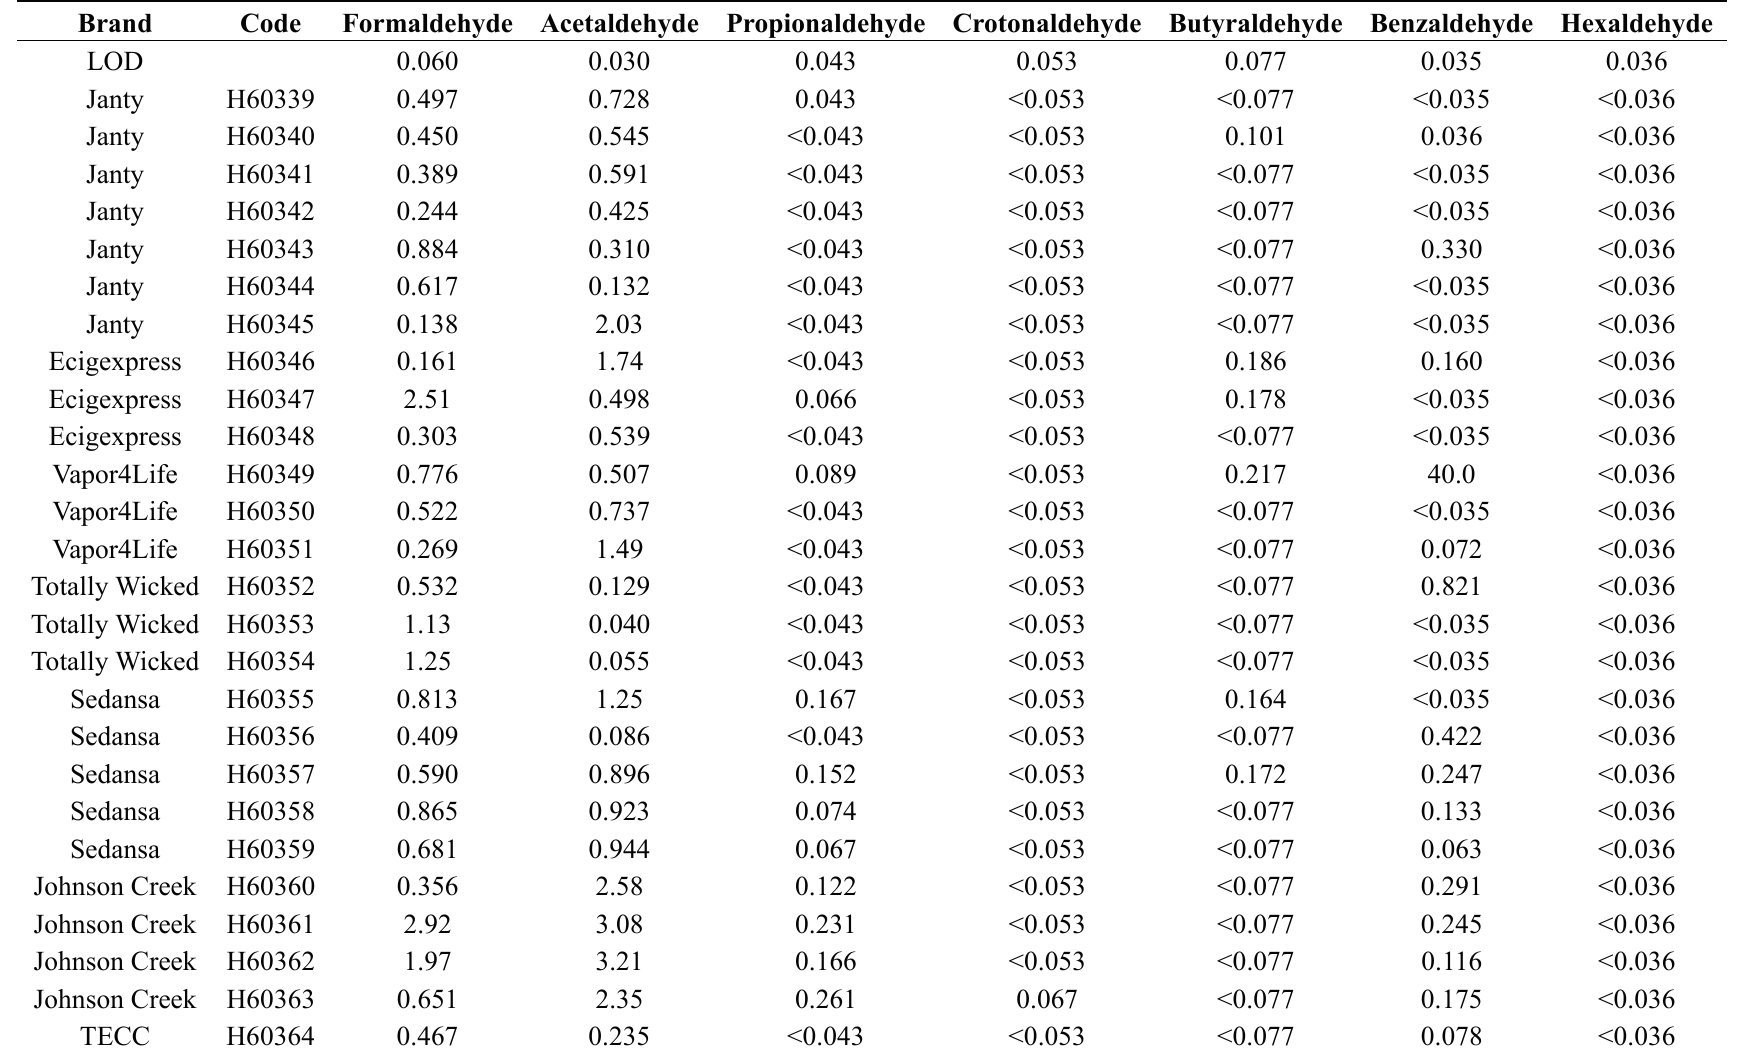
Table 3. Aldehydes (in µg/g) in 42 bottles of e-liquids,